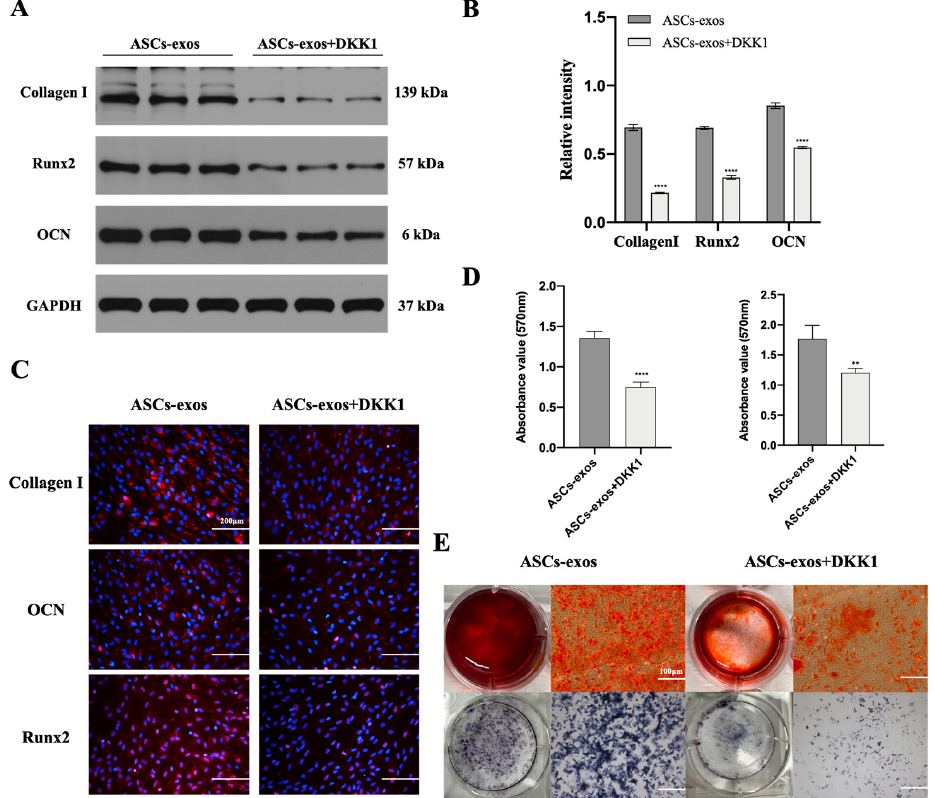
Figure 6. The positive effect of ASCs-exos on the osteogenic differentiation of BMSCs can be inhibited via DKK-1. ( A , B ) Decreased protein expression of collagen I, OCN and Runx2 due to the inhibition of Wnt3a/ β -catenin signaling pathway via DKK-1. ( C ) Immunofluorescence staining for collagen I, OCN and Runx2. ( D ) Alizarin red staining and ALP staining in BMSCs after 14 days in different groups. ( E ) The statistical analysis of ARS and ALPS. Scale bars, 100 μ m. Data are expressed as mean ± SD, and all experiments were repeated three times. ** p < 0.01, **** p < 0.001.